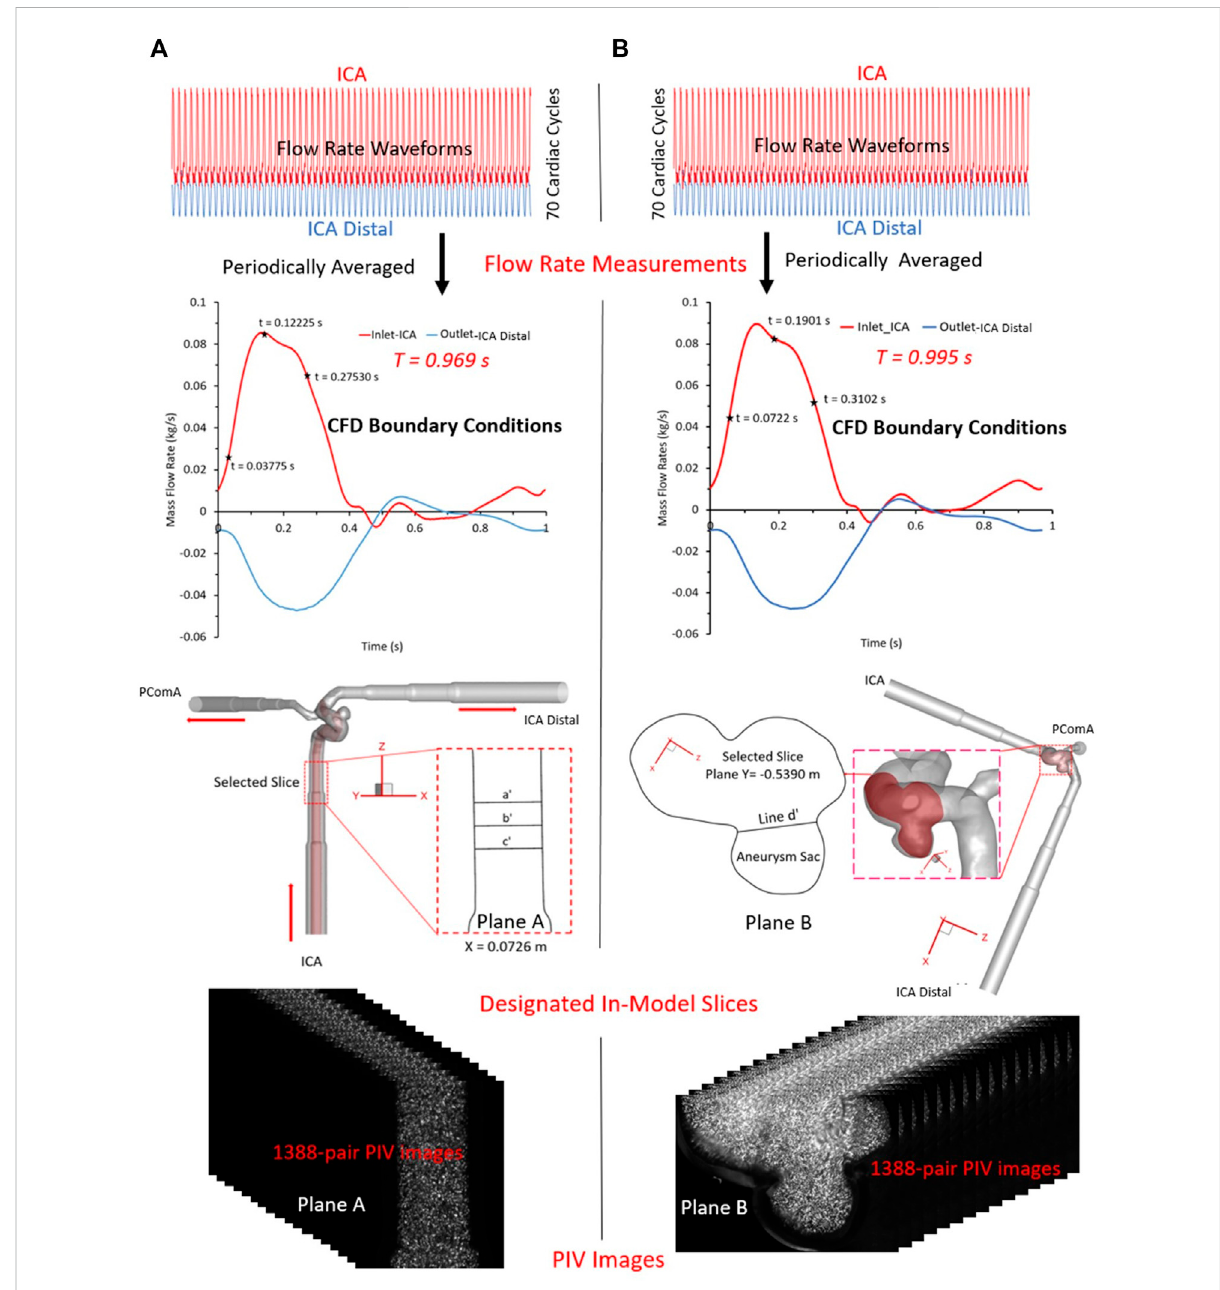
FIGURE 3 PIV measurements in the two selected planes: (A) plane X = 0.0726 m, and (B) plane Y = − 0.5390